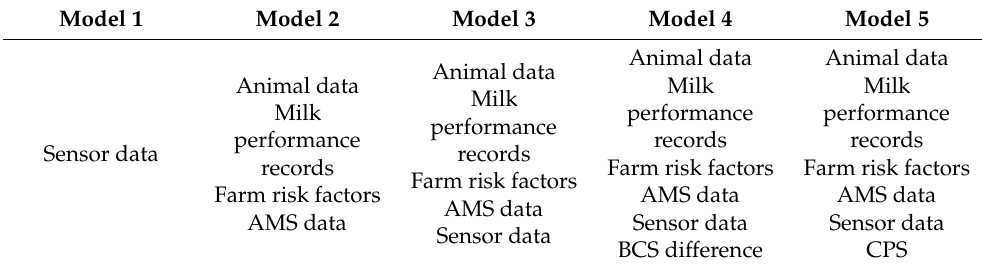
Table 2. Four different models with varying combinations of variables were